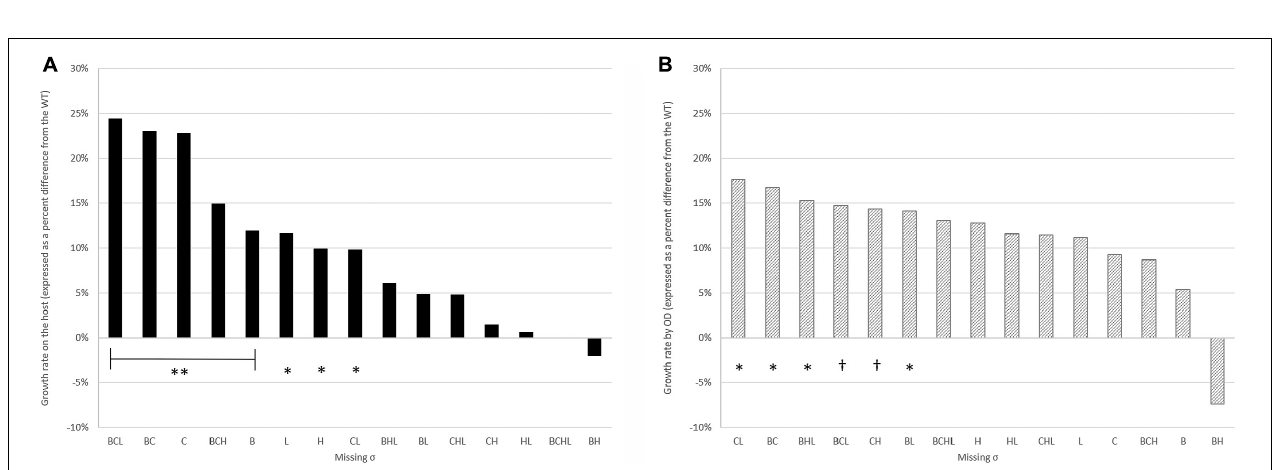
FIGURE 2 | Intracellular growth of 16 Listeria monocytogenes strains. Numbers of intracellular L. monocytogenes are shown in log CFU/well ( Y -axis). The X -axis shows time in hours post-infection. The dark gray bar represents WT 10403S L. monocytogenes , the yellow bars represent single deletion mutants, the green bars represent double deletion mutants, the blue bar represents triple deletion mutants, and the light gray bar represents quadruple mutant. The strains are ordered as seen in the legend on the right.